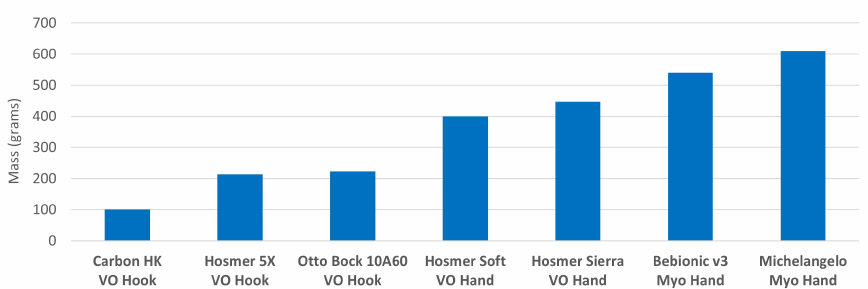
Figure 8. Carbon HK VO hook mass (left) compared to current state-of-the-art commercially available upper limb